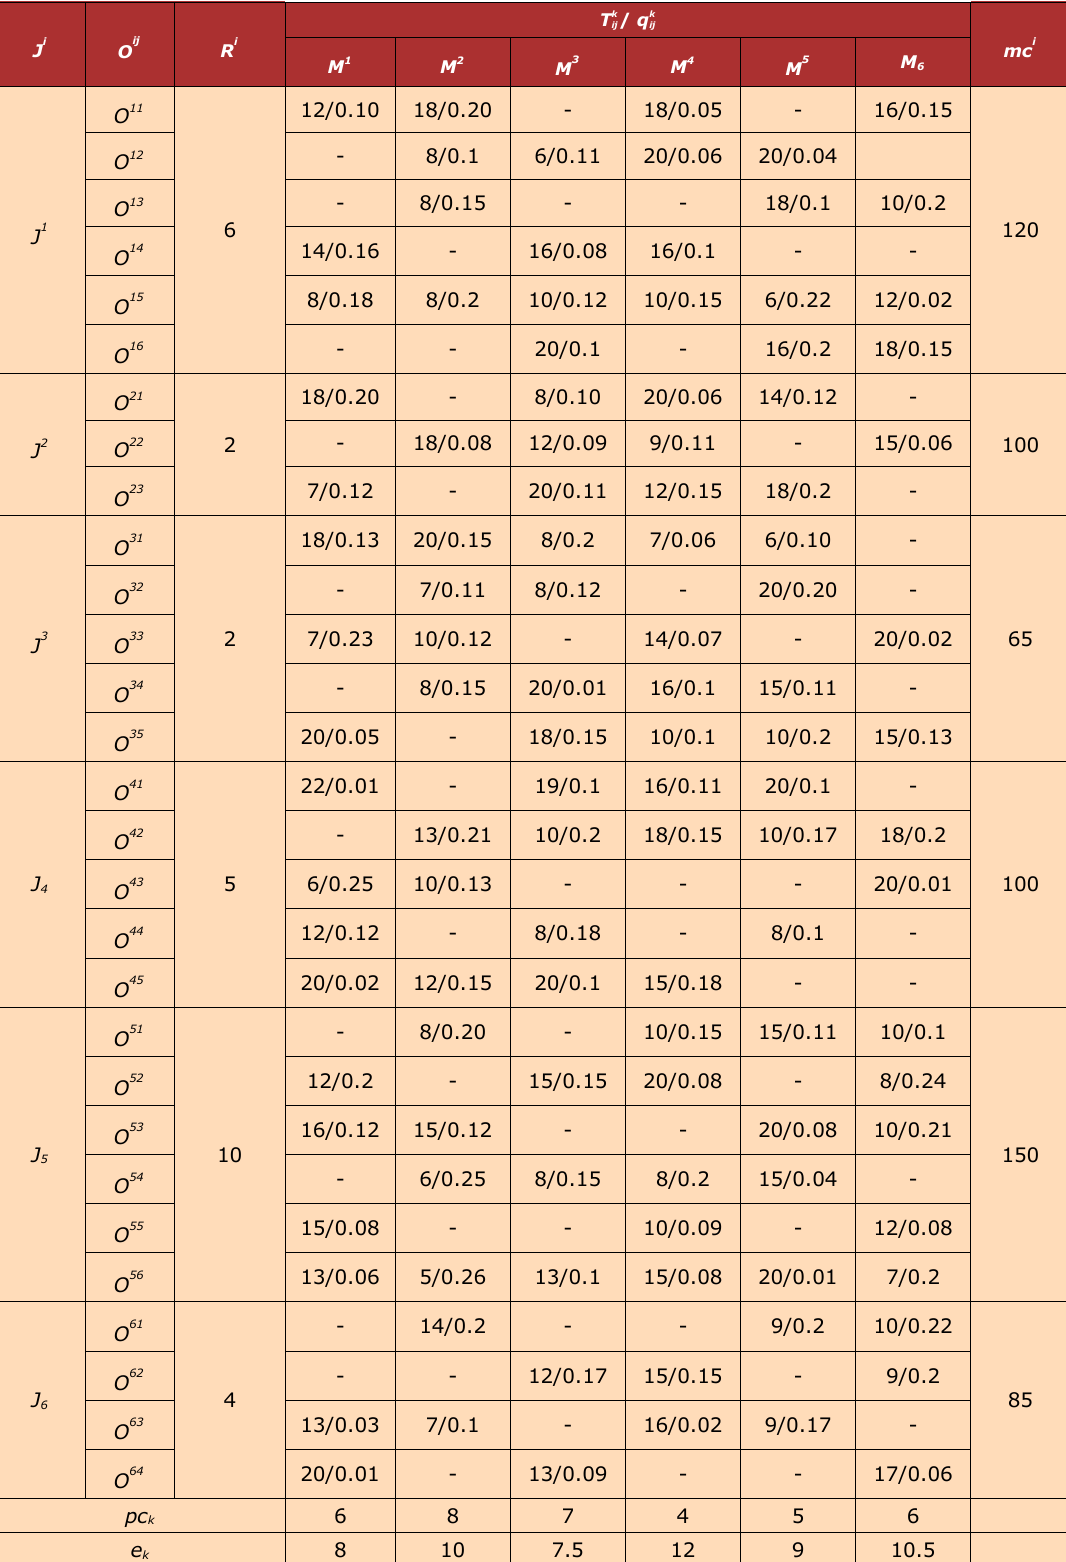
Table 1. Instance